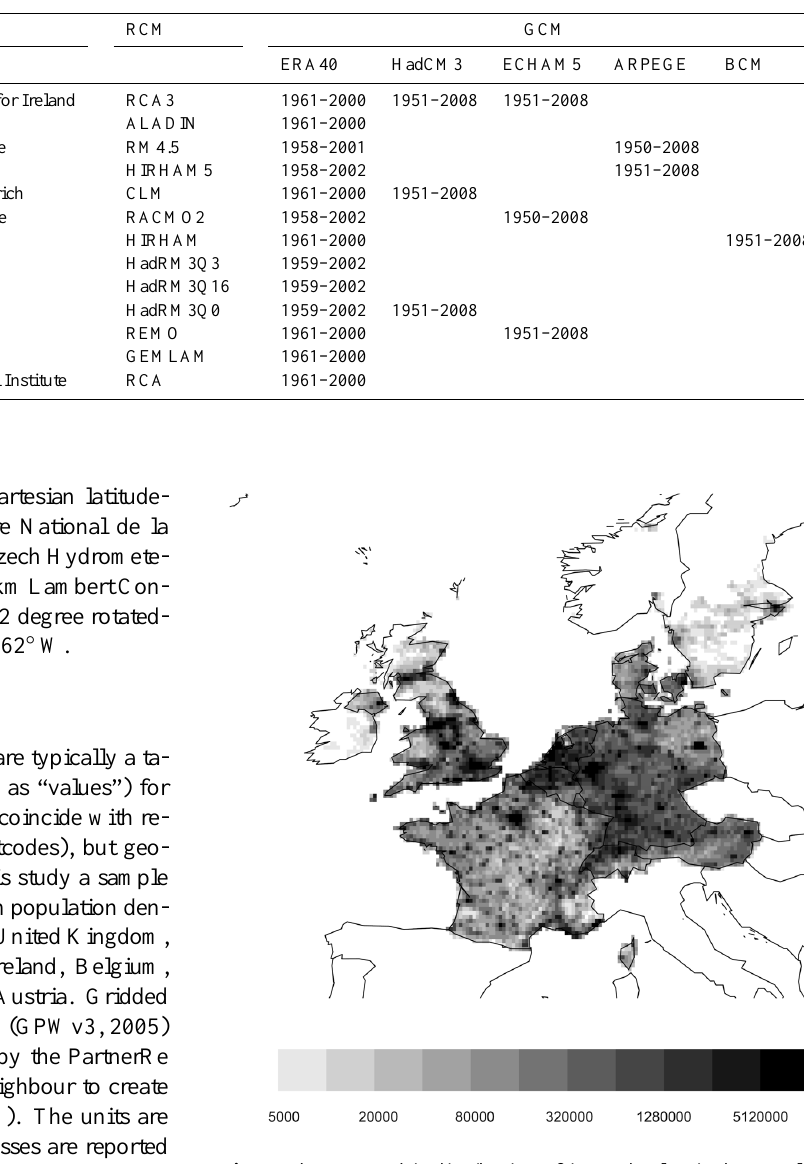
Table 1. Period of regional climate model runs with their driving global model.